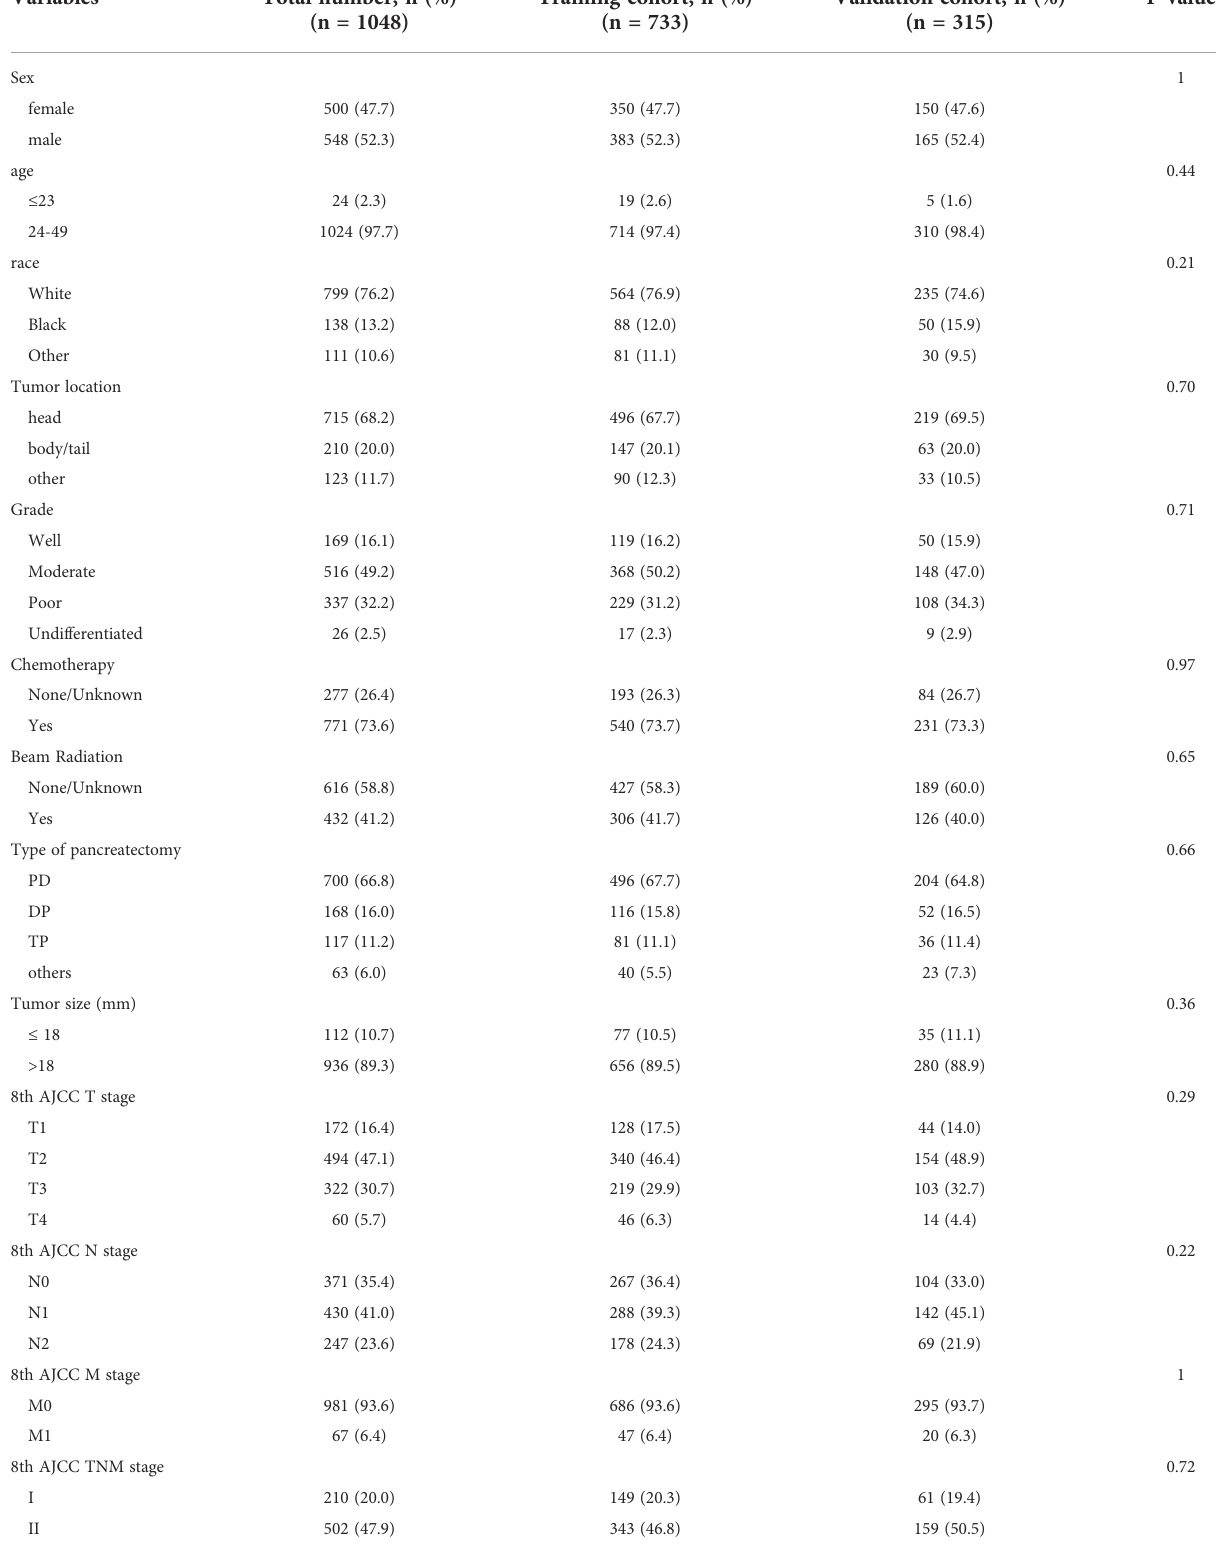
TABLE 1 Demographics and clinicopathologic characteristics of EOPC